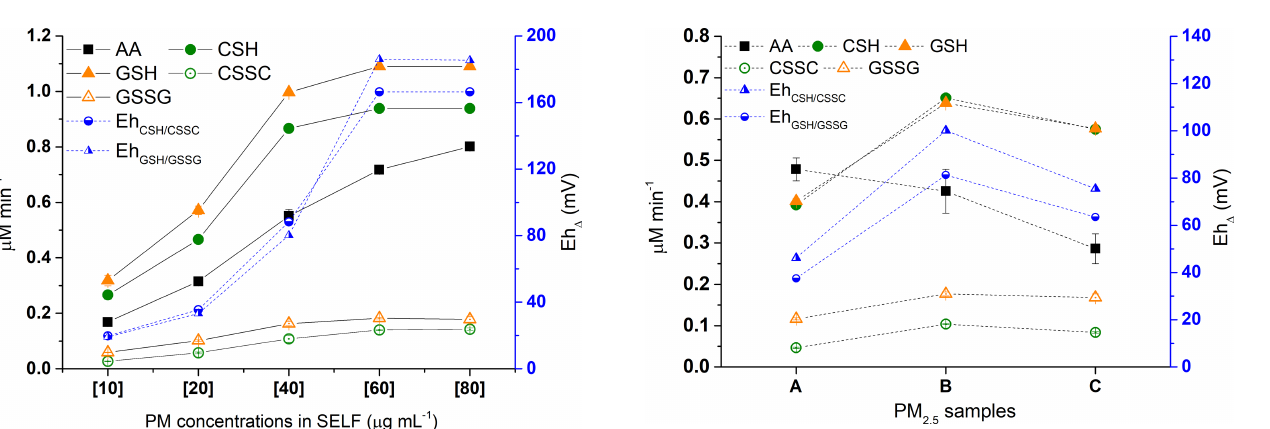
Figure 4. Dose response of antioxidants AA, CSH, and GSH de- pletion and oxidation products CSSC and GSSG formation due to increase in SRM concentration in SELF-a (left y axis) following 180min incubation; corresponding changes in the redox state of SELF calculated using the Nernst equation (Eh; right y axis), where (cid:49) denotes the difference in Eh between SELF containing PM and reference SELF.